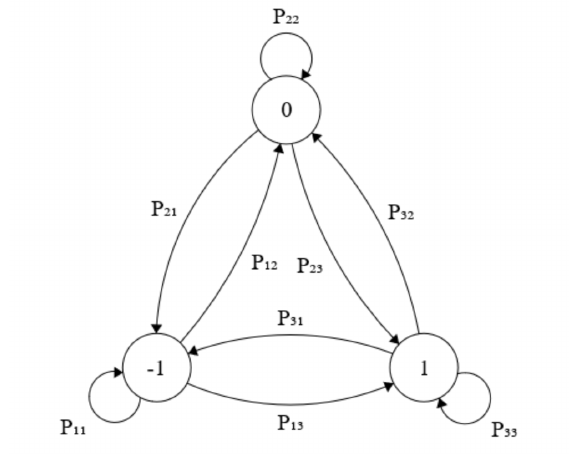
Figure 5. First–order Markov model.